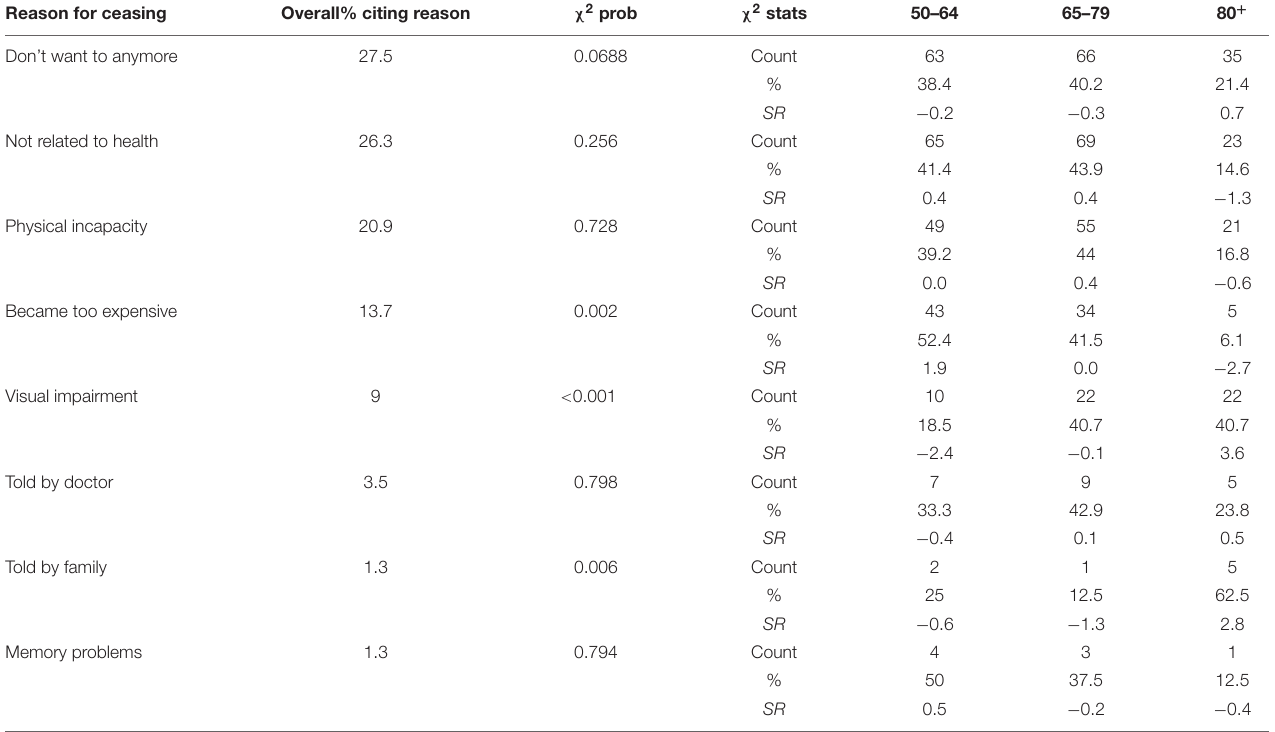
TABLE 4 | Key results from chi-square goodness of fit for age category by reason for ceasing. Reason for ceasing